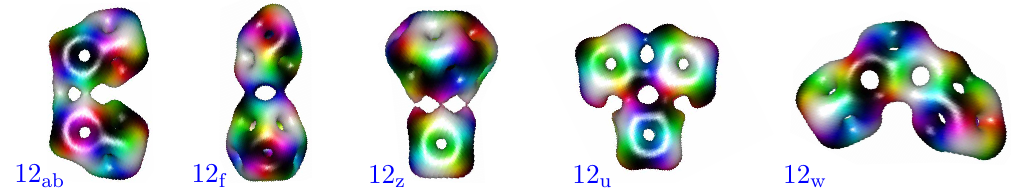
Figure 3. Some B = 12 Skyrmions made from smaller clusters.